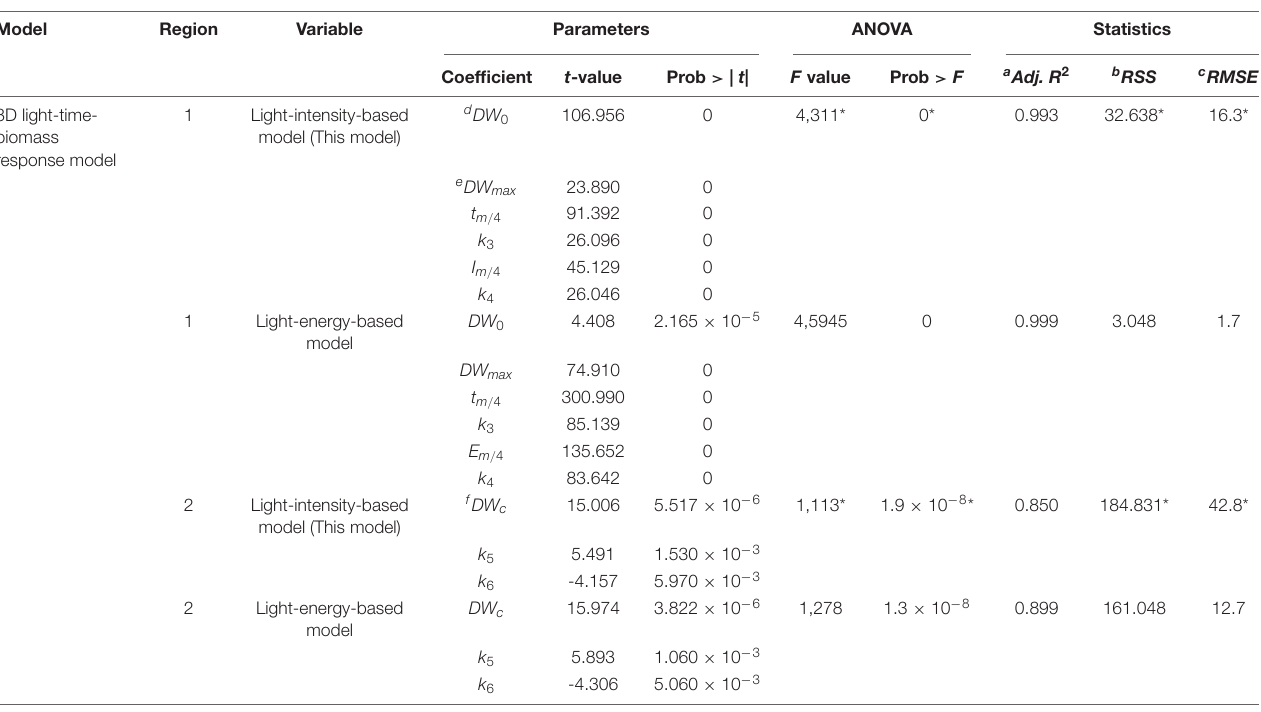
a Adj., adjusted. b RSS, residual sum of squares. c RMSE, root mean square error. d DW 0 , dry weight of choy sum seed portion that will be developed into the seedling. e DW max , the maximal dry weight achieved. f DW c , the coordinated dry weight in Region 2. RMSE unit for 3D light-time-biomass response model is “mg/seedling.” *Indicated that the data were also shown in Table 2 and Figure 2F for